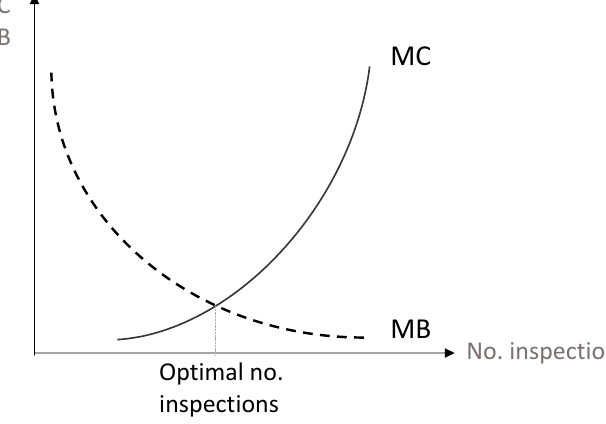
Figure 3. Relationship between marginal benefit and marginal costs of inspections.